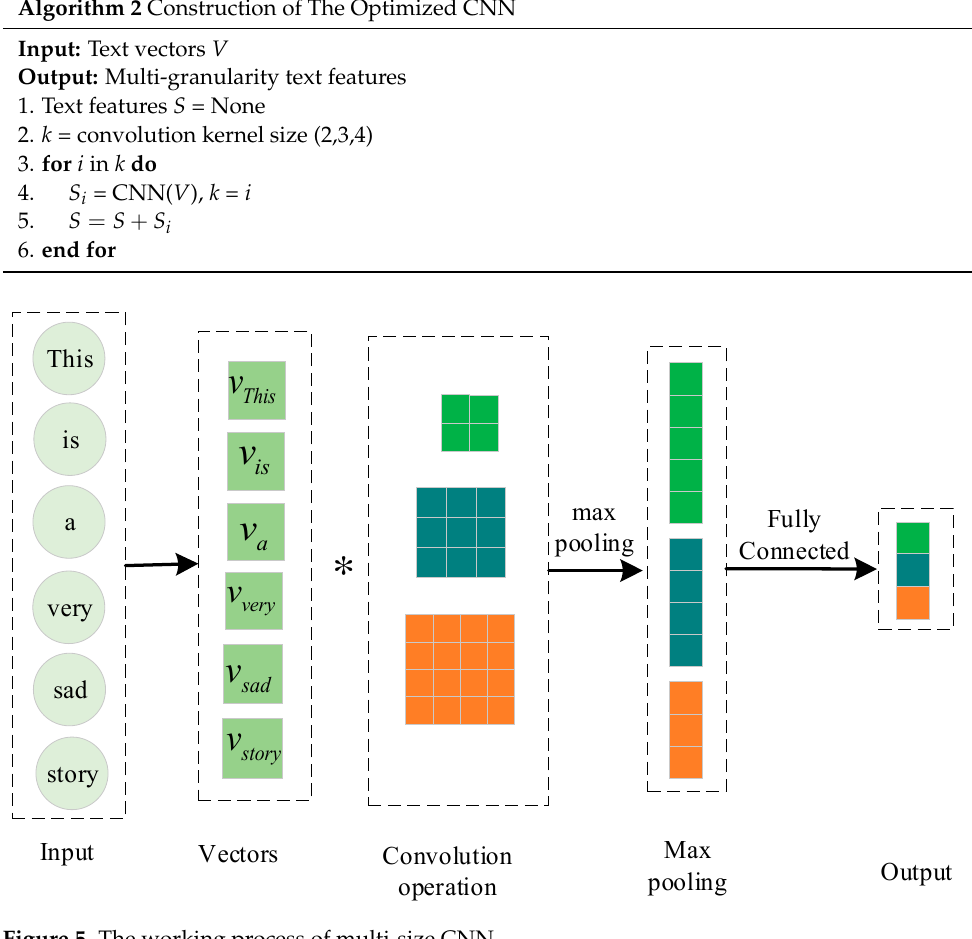
Figure 5. The working process of multi-size CNN.